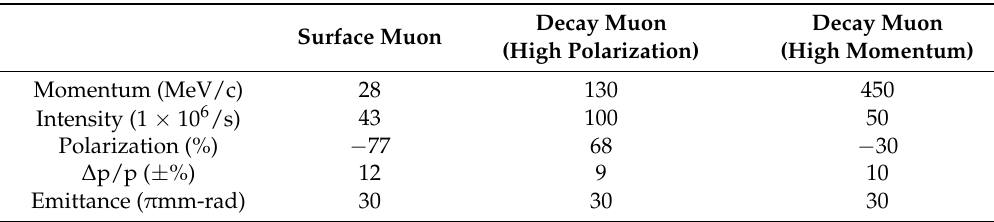
Table 1. Summary of the EMuS muon beam parameters. Decay Surface Muon